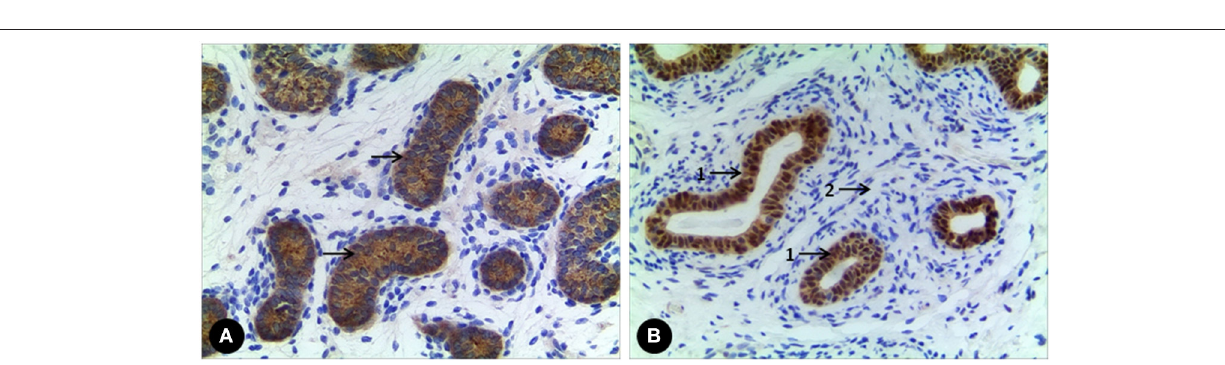
FIGURE 3 | (A) A case of vanishing testis showing Sertoli cell population with immunohistochemical cytoplasmic positivity for anti-AMH (arrow) in SNTs. (B) Another one showing Sertoli cell population with immunohistochemical nuclear positivity for anti-AR (arrow 1) in SNTs, but no Leydig cell with immunohistochemical positivity for anti-AR in interstitial space (arrow 2). Images under × 100 visual